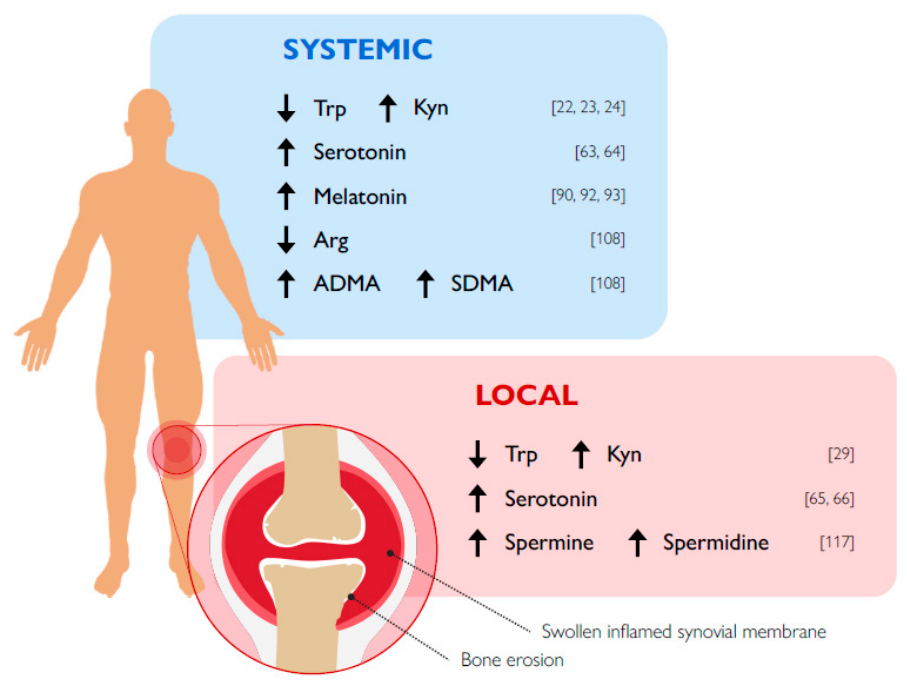
Figure 2. Schematic representation of significant changes in tryptophan and arginine metabolite levels in RA patients. Numbers on the rights represent relevant references.